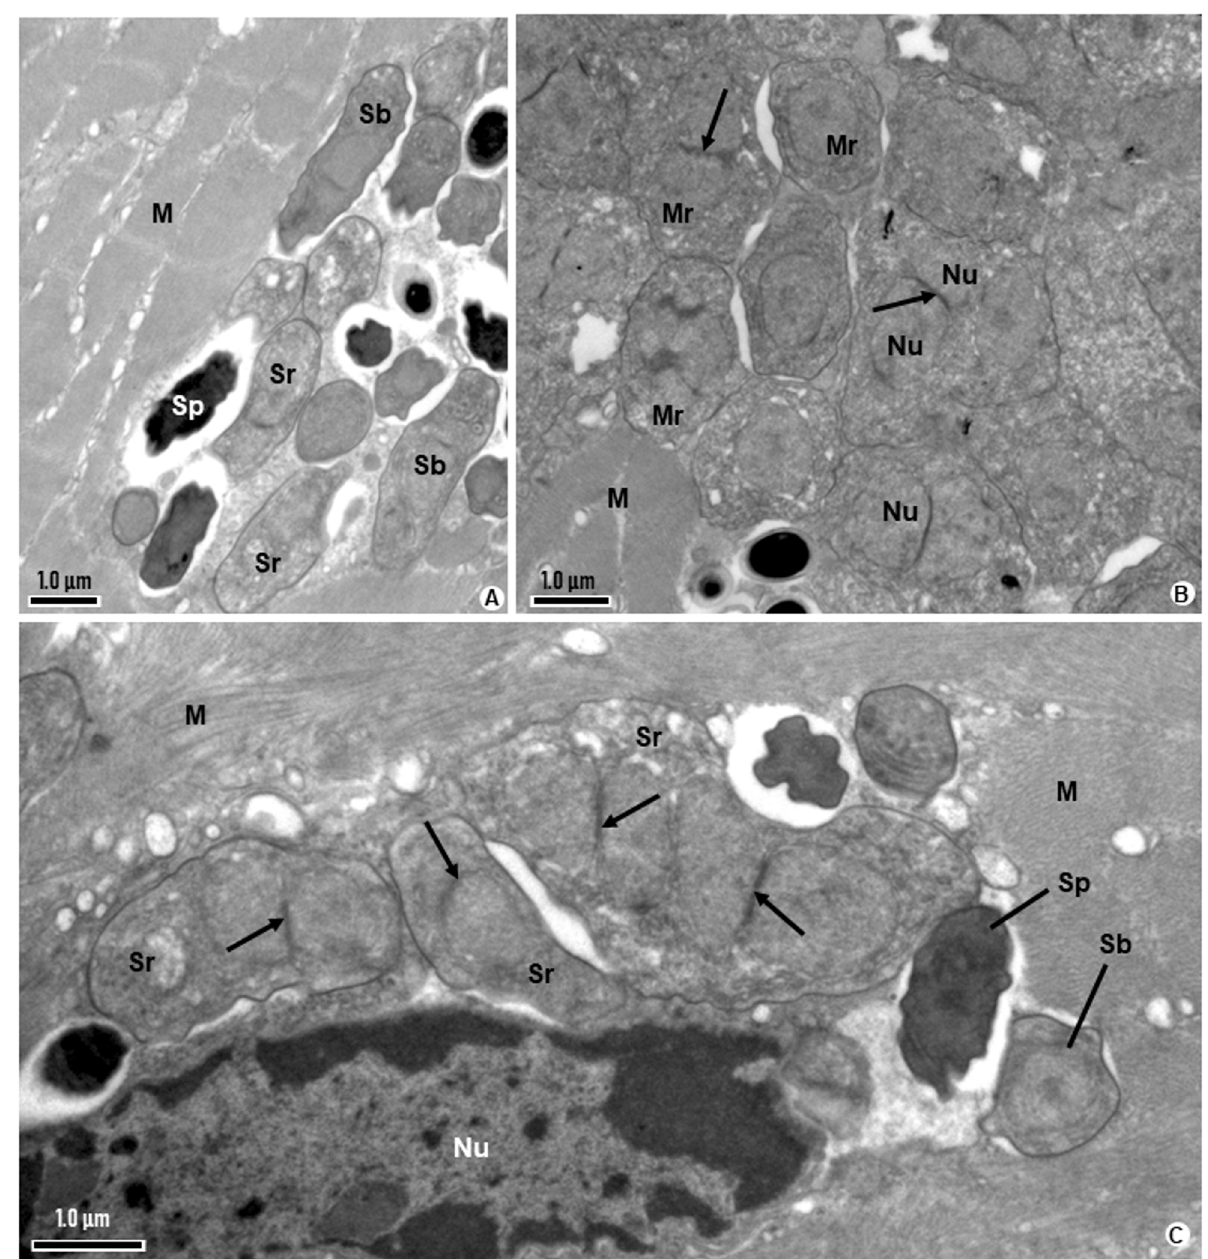
Figure 4. Ultrastructure of Myospora sp. ( A ) Spores (Sp), sporonts (Sr) and sporoblasts (Sb) in direct contact with muscle cells (M). ( B ) Meronts (Mr), some with diplokarya (arrows) are located in close contact with the cytoplasm of the muscle cell (M). ( C ) Detail of the muscle cell nucleus (Nu) surrounded by several sporonts (Sr), some of which are diplokaryons (arrows), a spore (Sp) and sporoblasts (Sb) in close contact with nuclear envelope. The muscle fibers show evident